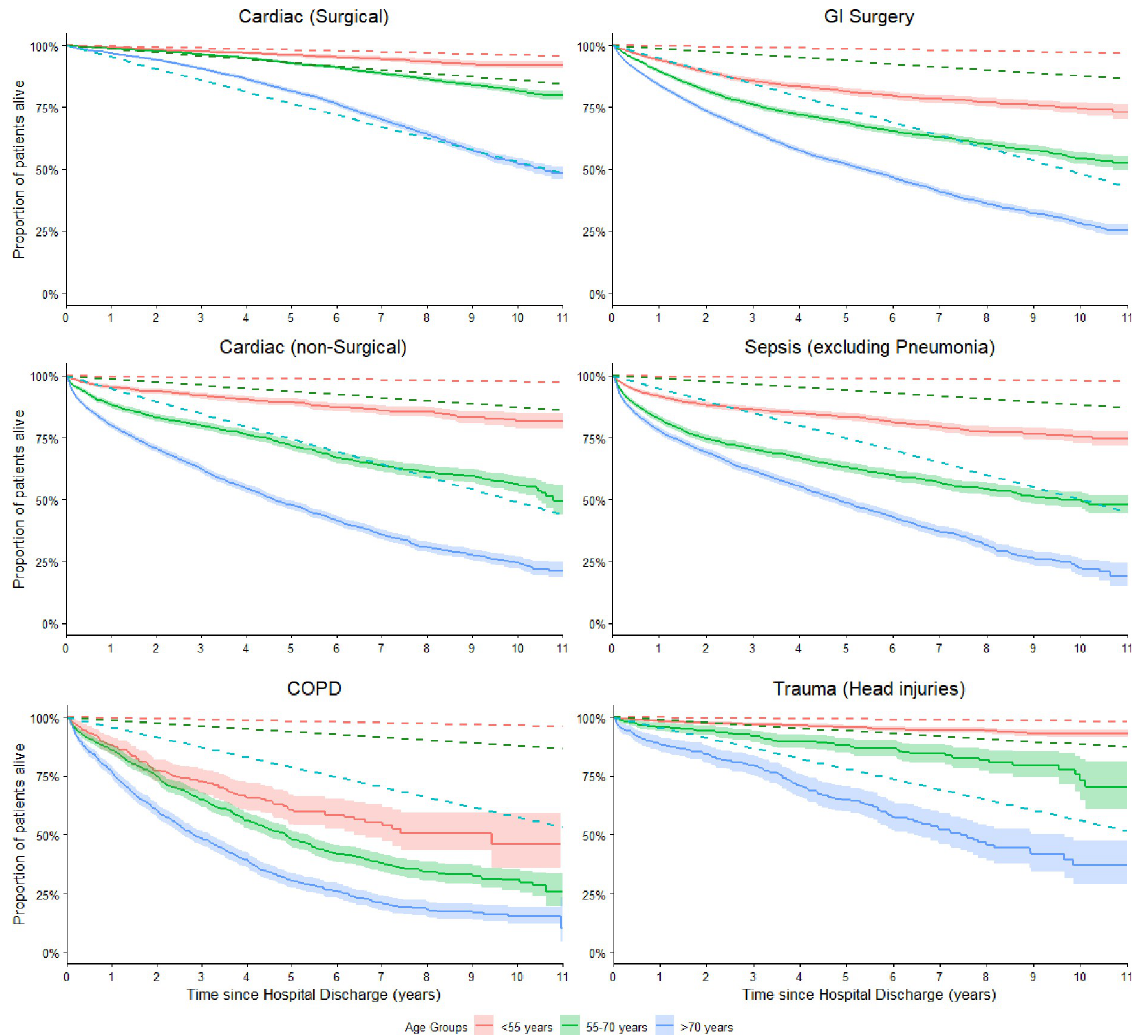
Fig 3. Survival curves of diagnosis groups stratified by age group (solid lines) compared to the matched standard Australian population (dotted lines). The 95% confidence intervals of the study cohort lines are represented by the shaded areas. Groups: Cardiac (Surgical) (N = 14438), GI Surgery (N = 14450), Cardiac (non-Surgical (N = 8271), Sepsis (excl. Pneumonia) (N = 8581), COPD (N = 2608), Trauma (Head injuries) (N = 2725). GI; Gastrointestinal, COPD; Chronic Obstructive Pulmonary Disease.